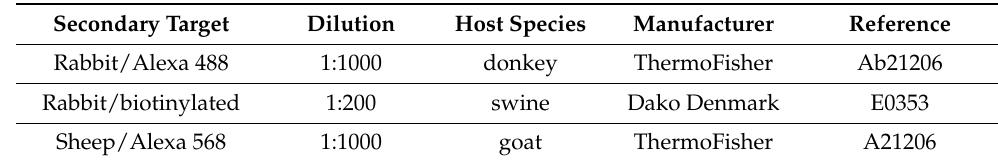
Table 3. This table depicts the list of secondary antibodies used in the present study. The source, host species, and dilution are